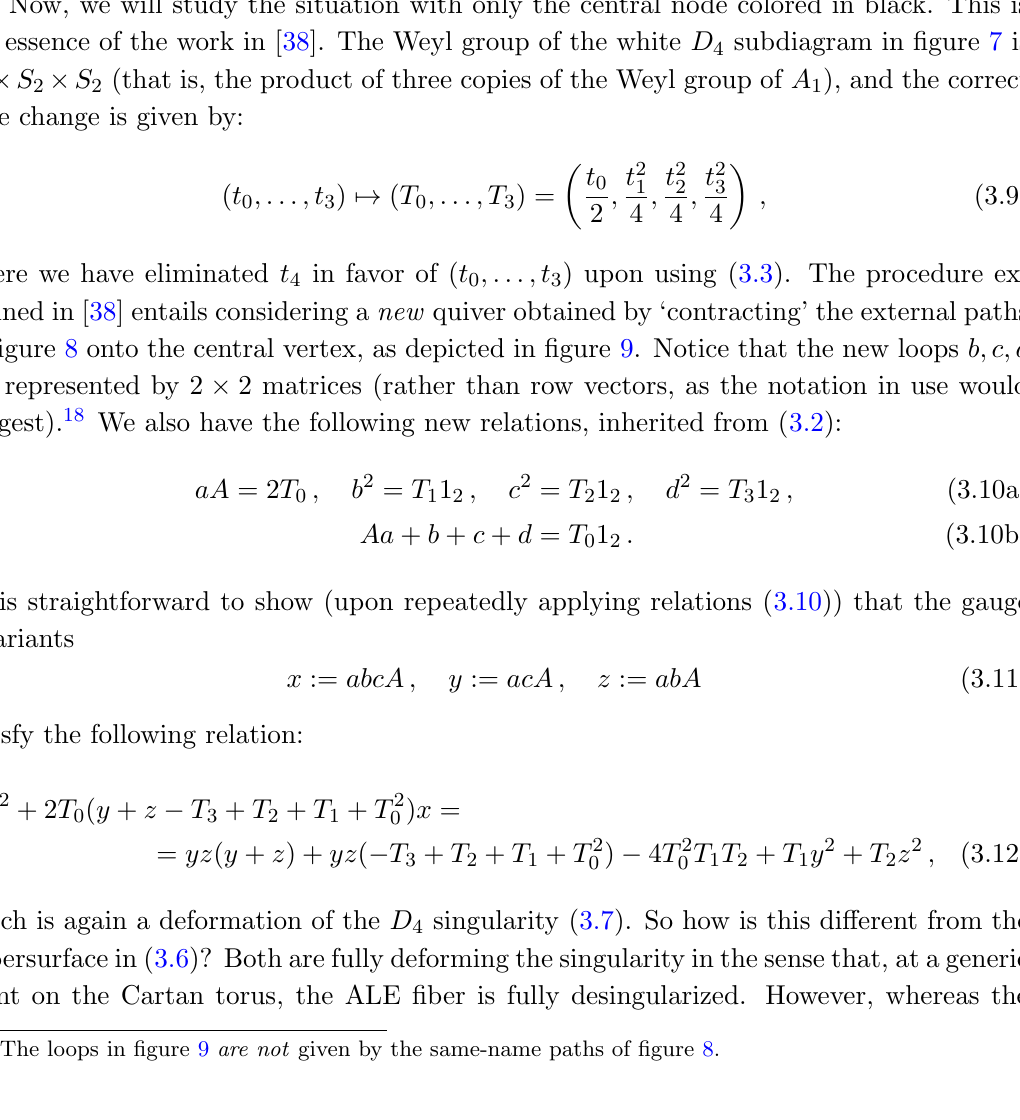
Figure 9 . The quiver with relations reproducing the threefold family of deformed D singularities admitting a simultaneous